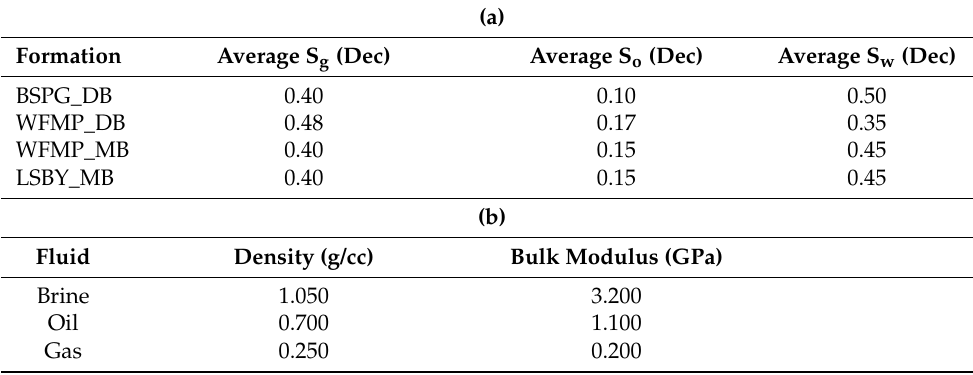
Table 3. (a) Average laboratory-measured fluid saturations. S g is gas saturation, S o is oil saturation, and S w is brine saturation. In situ S g = 0 for all four formations considered in this section. Lab S w = In situ S w . (b) Fluid Properties required for fluid substitution to in situ fluid